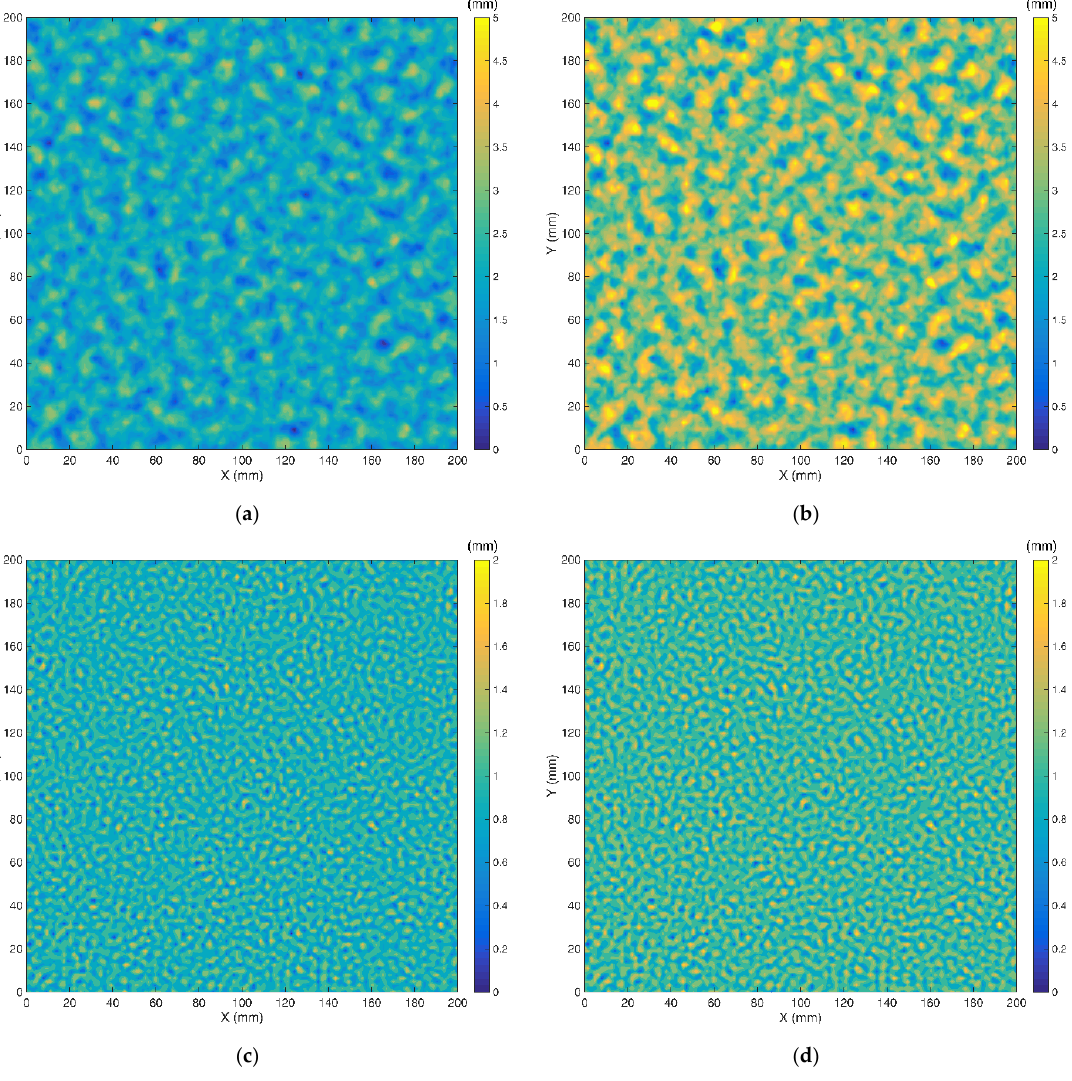
Figure 1. Aperture distribution of: ( a ) Fracture ‐ 1; ( b ) Fracture ‐ 2; ( c ) Fracture ‐ 3; ( d ) Fracture ‐ 4. For each synthetic fracture generated, the fractured planes were built with a physical size of 200 mm × 200 mm. A 3D printer has been used to construct these profiles on two plastic sheets in order to represent the two fracture planes (Figure 2). The thickness of printed fractures was 0.05 mm larger than the largest aperture, which reduced computa- tional cost. The 3D printed fracture planes were then placed into formwork molds, whereby transparent epoxy resin was poured in order to create a transparent epoxy resin block with a single fracture. Upon setting of the resin, the two fracture surfaces were positioned together and sealed, watertight, down both